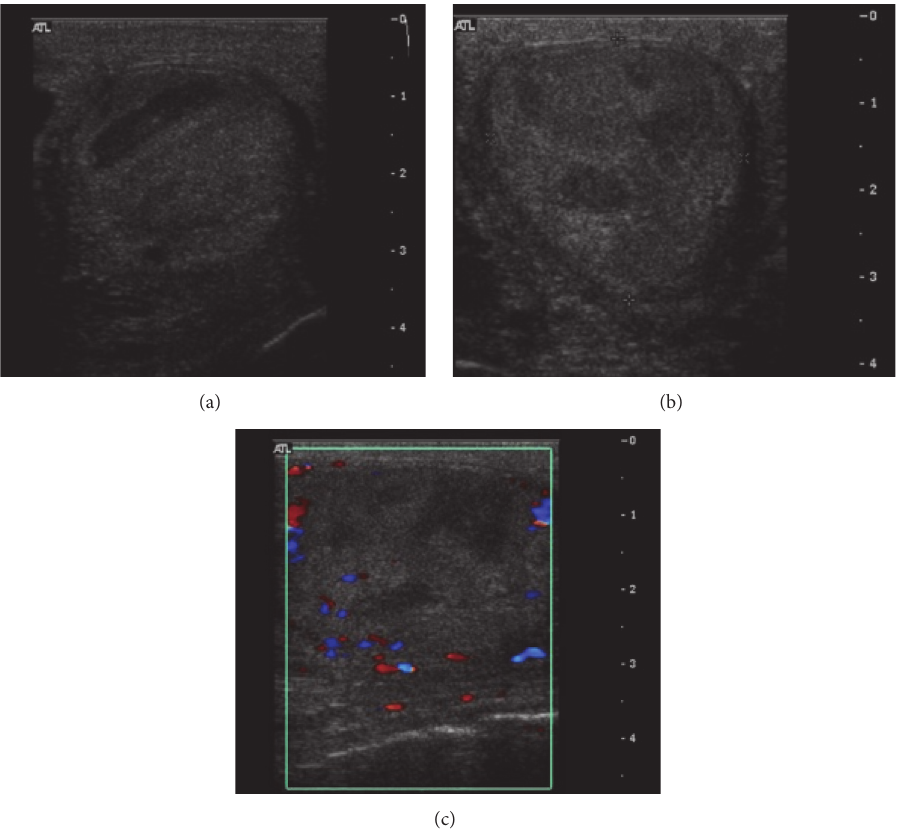
Figure 1: Multiple axial and longitudinal sonographic images (a–c) of the left testicle with Doppler color demonstrating a heterogeneous appearance, with multiple hypoechoic mass-like areas, and lack of Doppler flow within the majority of the testis. The right testis (image not provided) had a similar appearance.